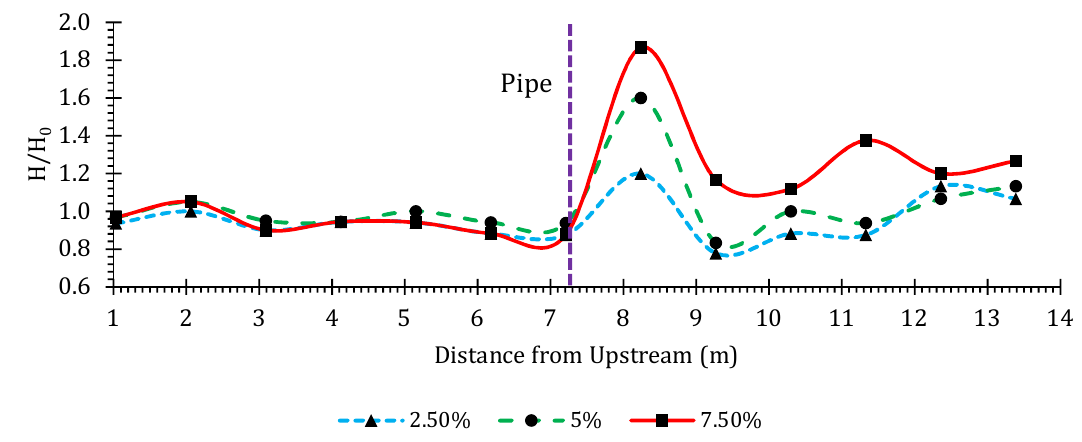
Figure A42. Water height ratios in a 90° junction for Fr = 2.80 in the narrow channel.